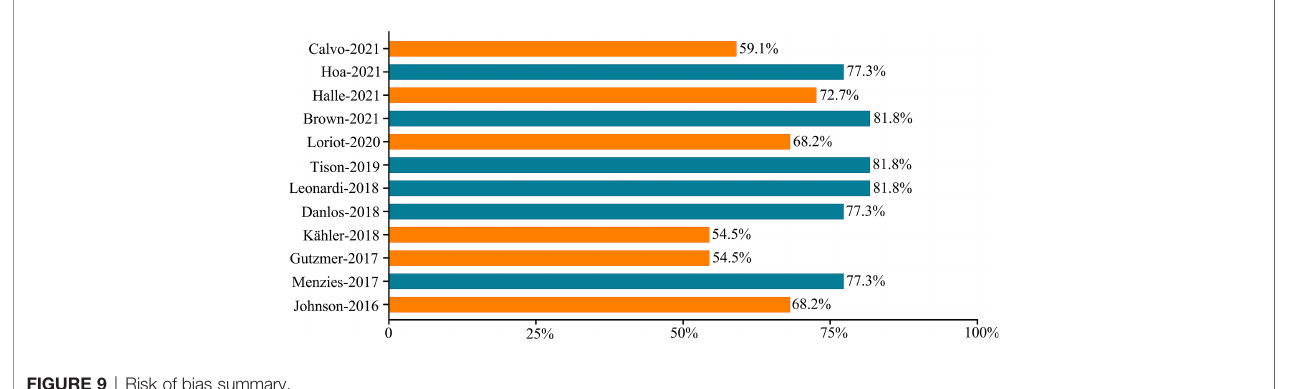
FIGURE 9 | Risk of bias summary.